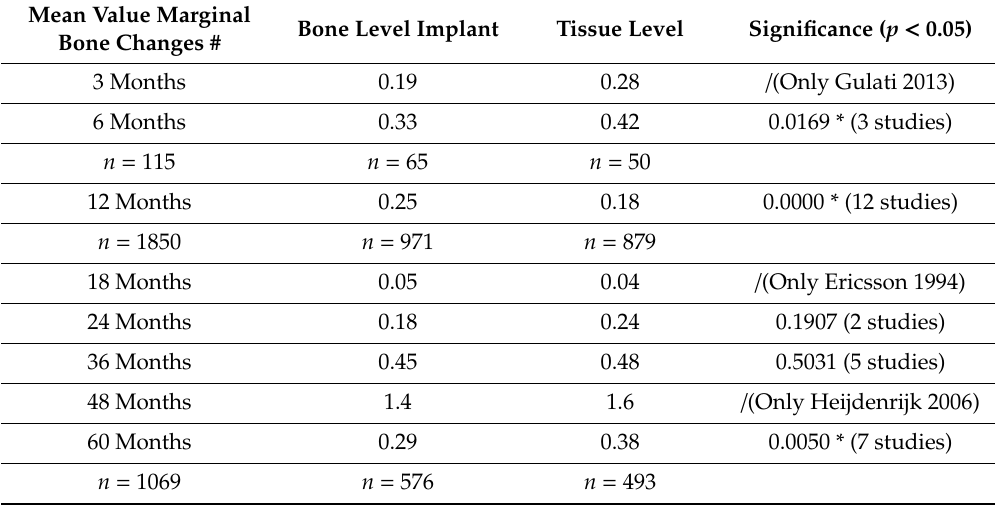
Table 3. The mean values of marginal bone loss (changes) in relation to the number of implants of each study with corresponding p -values. Mean Value